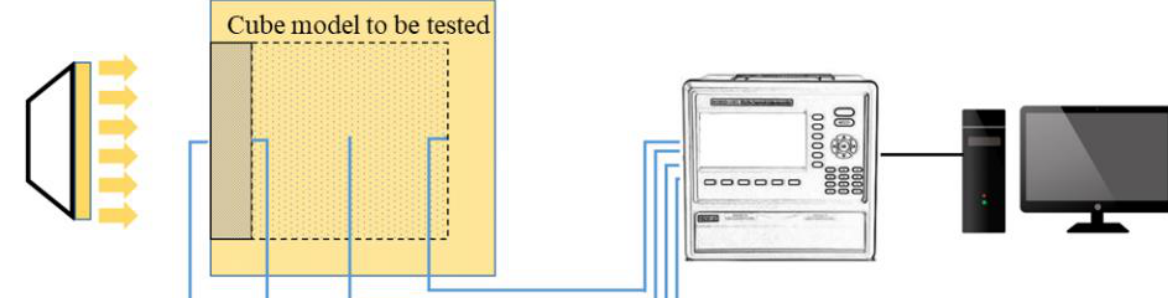
Figure 4. Test system for the single-side heating performance of concrete slabs.